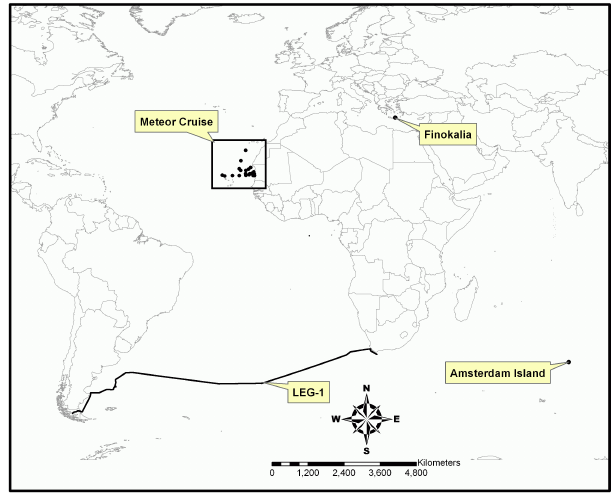
Figure 1. Sampling sites around the world during this study. Fi- nokalia station is used for comparison